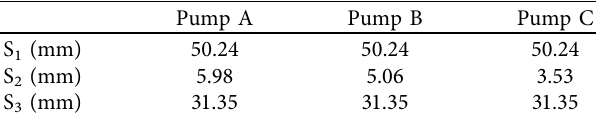
Figure 1: The structure of the pump: (a) exploded view of the VPPSFT where 1: the flow tube A, 2: the flow tube B, 3: pump body, and 4: piezoelectric vibrator; (b) sectional view of the flow tube; (c) the larger version of the main runner of the flow tube. Table 1: Main size parameters of the